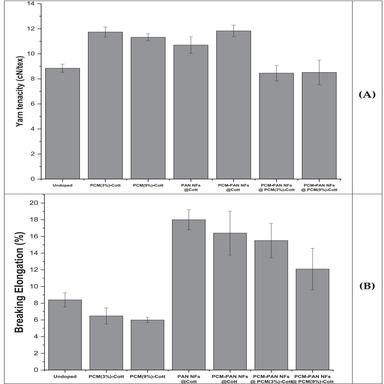
Tenacity (A) and breaking elongation (B) results of the yarn samples.